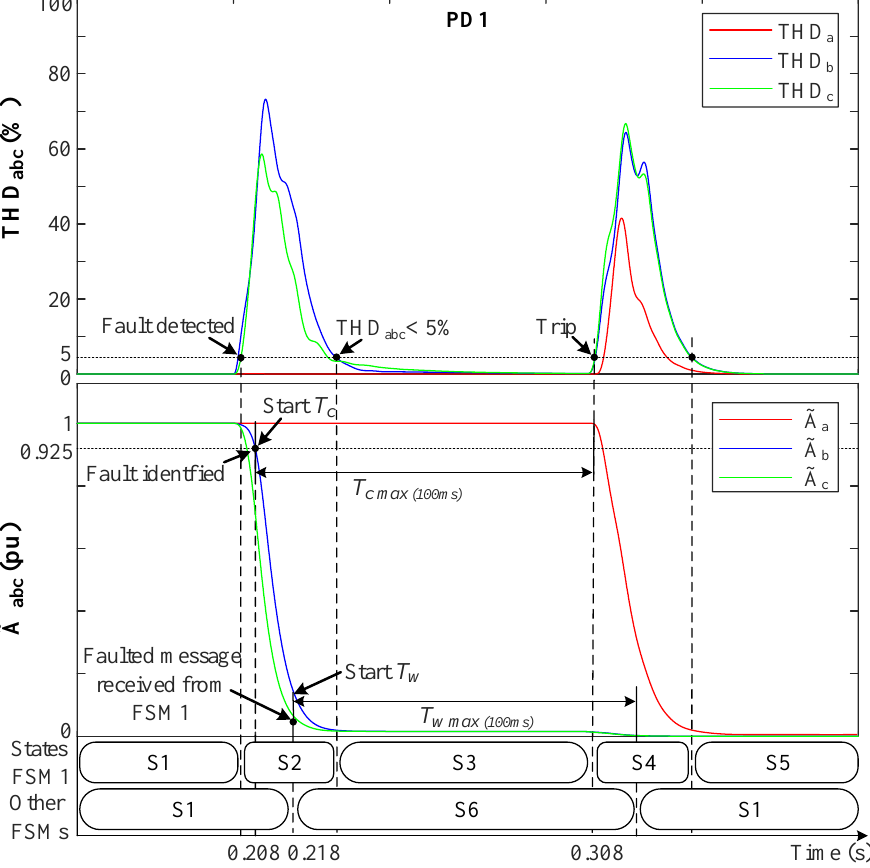
Figure 11. The system behavior with the FSMs during a 2PH-G fault at F1. ( Upper ) 𝑇𝐻𝐷 𝑎𝑏𝑐 . ( Lower ) 𝐴̃ 𝑎𝑏𝑐 .